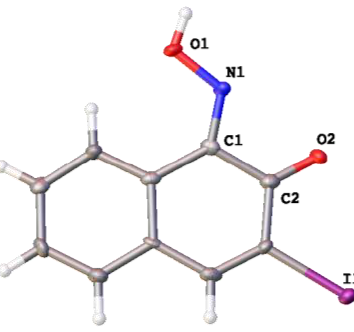
Figure 1. View of the molecular structure of I-NON obtained from XRD study. Nonhydrogen atoms are given as probability ellipsoids of atomic displacements ( p = 0.5).